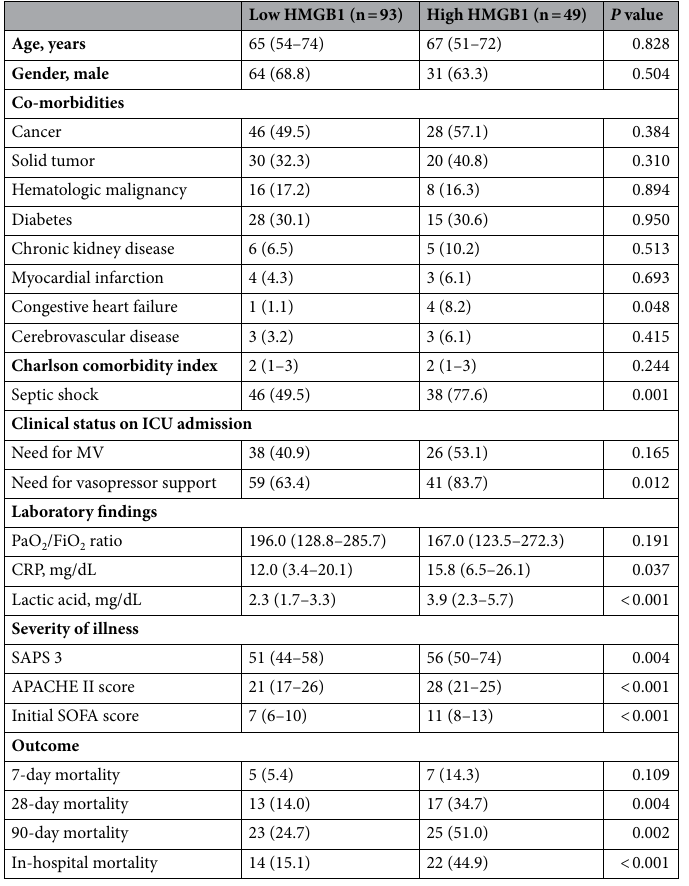
Table 2. Characteristics of patients with sepsis stratified according to the best cut-off level of plasma HMGB1 from the derivation cohort (n = 142). APACHE II, acute physiology and chronic health evaluation II; CRP, C-reactive protein; ICU, intensive care unit; MV, mechanical ventilation; PaO 2 /FiO 2 , arterial partial pressure of oxygen/fraction of inspired oxygen; SAPS 3, simplified acute physiology score 3; SOFA, sequential organ failure assessment.